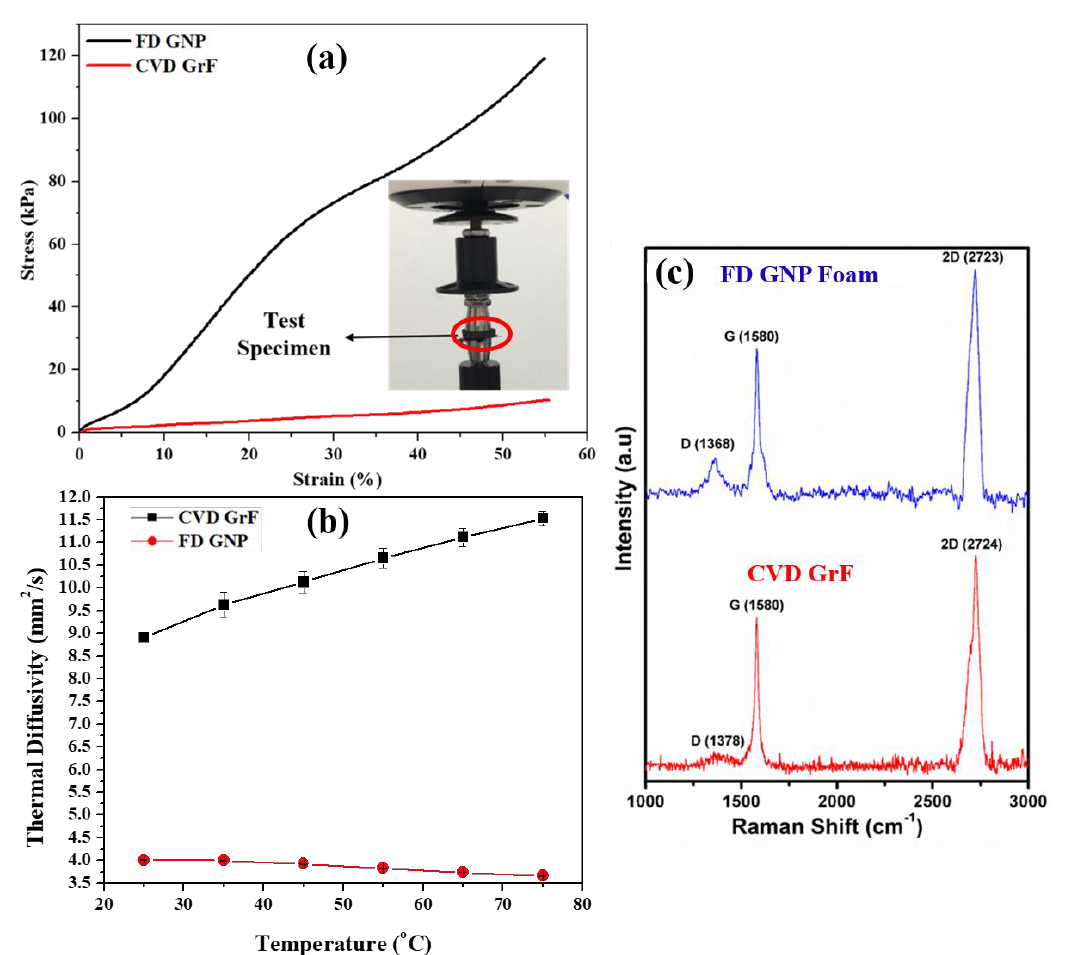
Figure 9. ( a ) Compressive stress vs. strain plot comparison of FD GNP foam and CVD GrF; ( b ) thermal diffusivity of FD GNP foam vs. CVD GrF; and ( c ) Raman spectra of FD GNP foam and CVD GrF.